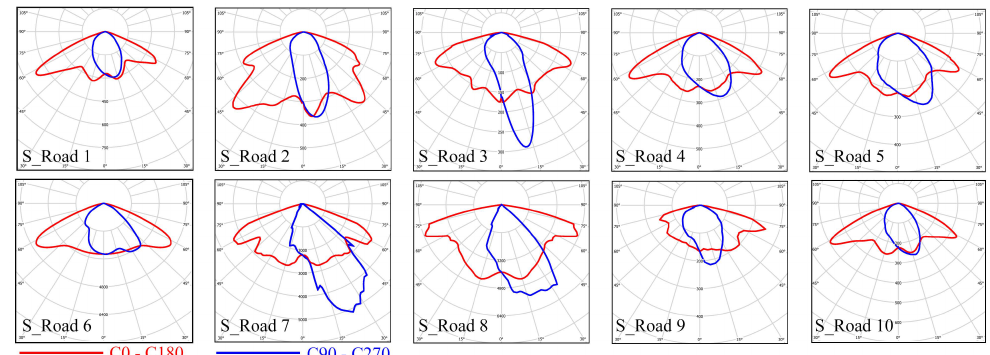
Figure 6. Photometric curves of the 10 different luminaires. The S_Roads represent the 10 simulated road lighting configurations. S_Roads 1, 2, 3, 4, 5, 9 and 10 are HID lamps, and S_Roads 6, 7 and 8 are LED luminaires. Wattages and lumen outputs: S_Road 1, 259 W & 27,000 lm; S_Road 2, 261 W & 20,500 lm; S_Road 3, 201 W & 20,500 lm; S_Road 4, 153 W & 14,500 lm; S_Road 5, 149 W & 14,500 lm; S_Road 6, 91 W & 10,280 lm; S_Road 7, 108 W & 11,000 lm; S_Road 8, 105 W & 11,690 lm; S_Road 9, 372 W & 20,000 lm; S_Road 10, 253 W & 20,500 lm.